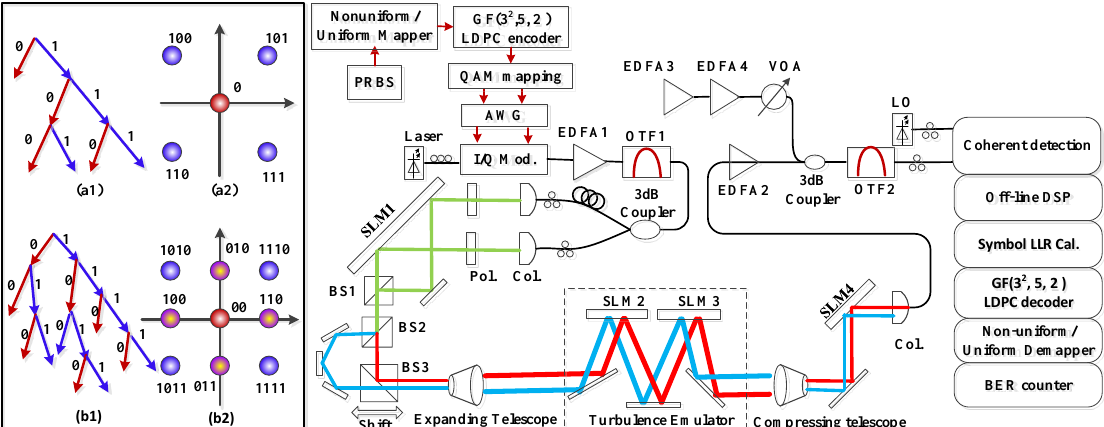
Figure 4. Experimental setup for the joint Huffman and LDPC coding enabled FSO communication system. Insets: ( a1 ) Huffman tree for 5-size alphabet; ( a2 ) 5-QAM format with bit labeling; ( b1 ) Huffman tree for 9-size alphabet; ( b2 ) 9-QAM format with bit labeling .